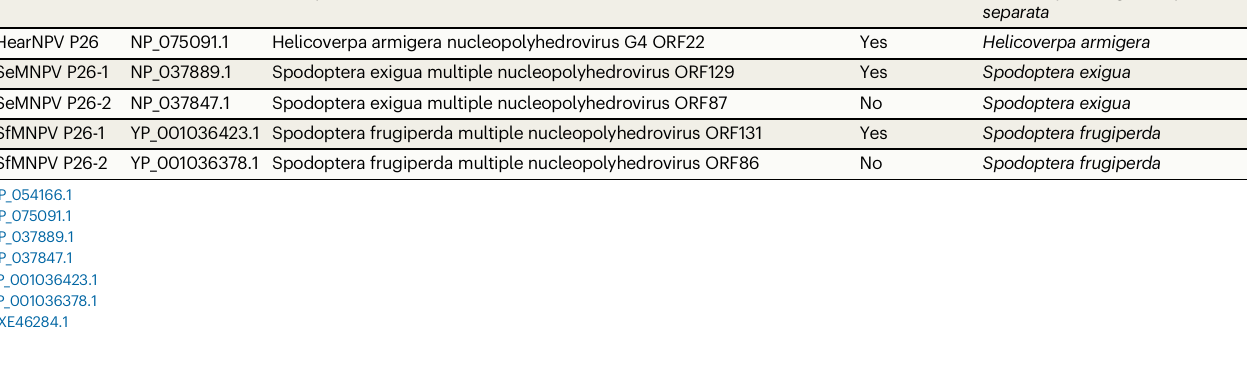
Fig. 1 | Comparison of 2 ′ 3 ′ -cGAMP nuclease activities and the active sites of different sources. a Phylogenetic relationship of poxin/P26 homologs from pox- viruses, parasitoidwasps, alphabaculoviruses, betabaculoviruses, cypoviruses, and lepidopteraninsects.Numbersonthenodesindicatethemaximum-likelihood(ML) tree nonparametric bootstrap supports over 50 (1000 replicates). b ELISAanalysis of2 ′ 3 ′ -cGAMPdegradationactivitiesofselectedpoxin/P26proteins(namesinbold in a ). Values are expressed as mean±s.e.m of three independent experiments. Statistical signi fi cance of differences was evaluated via two-tailed student ’ s t test.